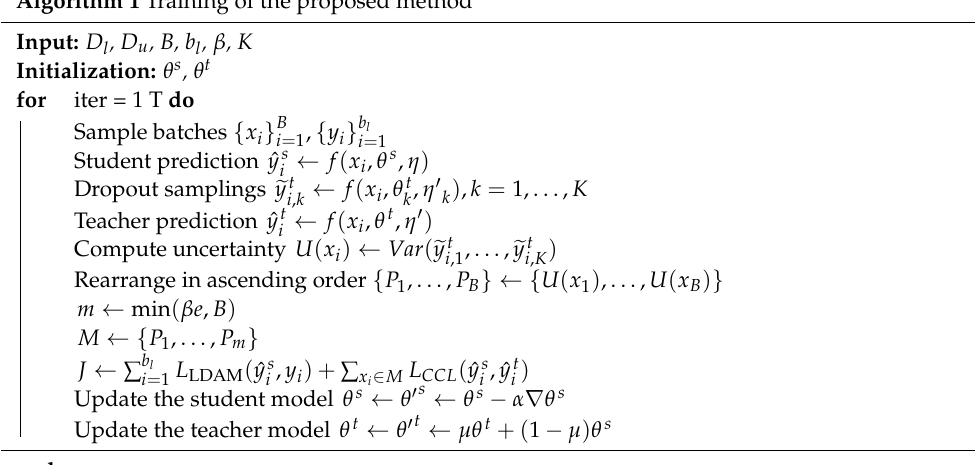
Algorithm 1 Training of the proposed method